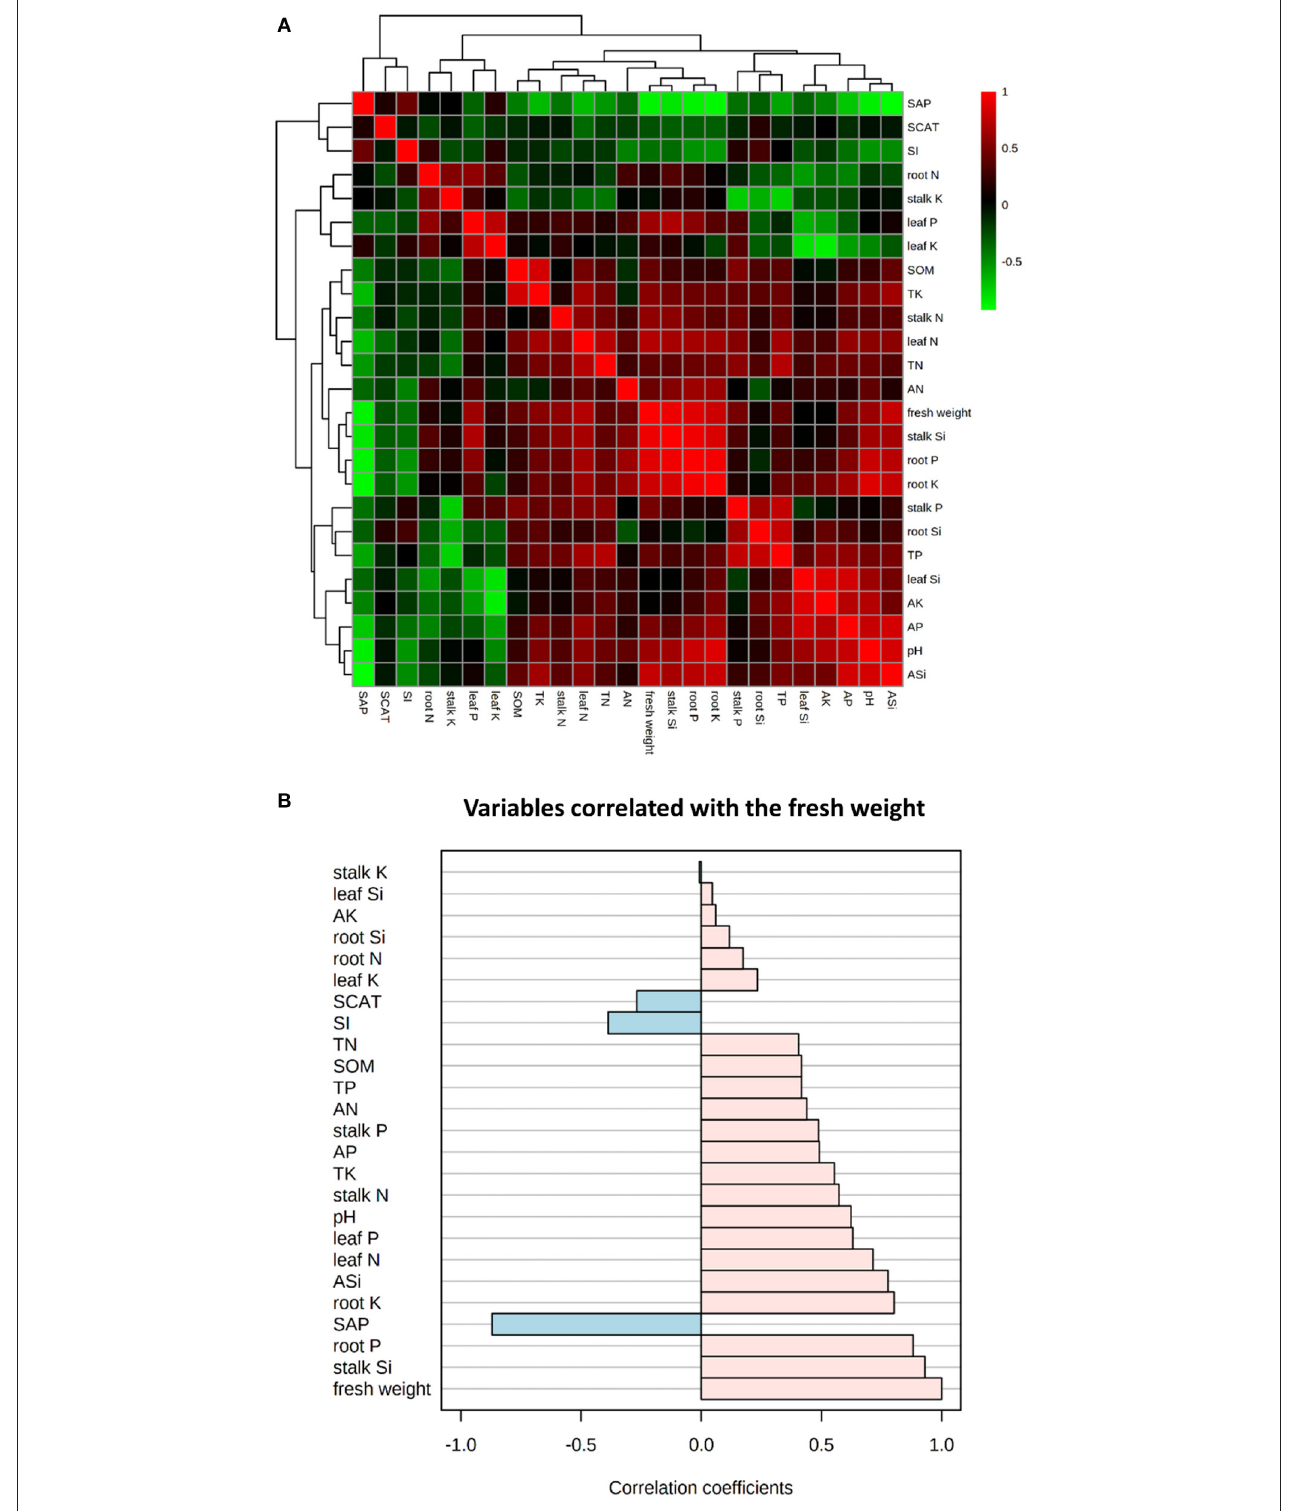
FIGURE 1 | The heatmap (A) for fresh weight and the investigated parameters, and the top 25 parameters correlated with fresh weight (B) . Red and green grids represent positive and negative correlation, respectively; the brighter the color, the stronger the correlation, and vice versa. ASi, available Si; AN, alkali hydrolyzed nitrogen; AP, available phosphorus; AK, available potassium; TN, total nitrogen; TP, total phosphorus; TK, total potassium; SOM, soil organic matter; SAP, soil acid phosphatase; SCAT, soil catalase; SI, soil invertase.